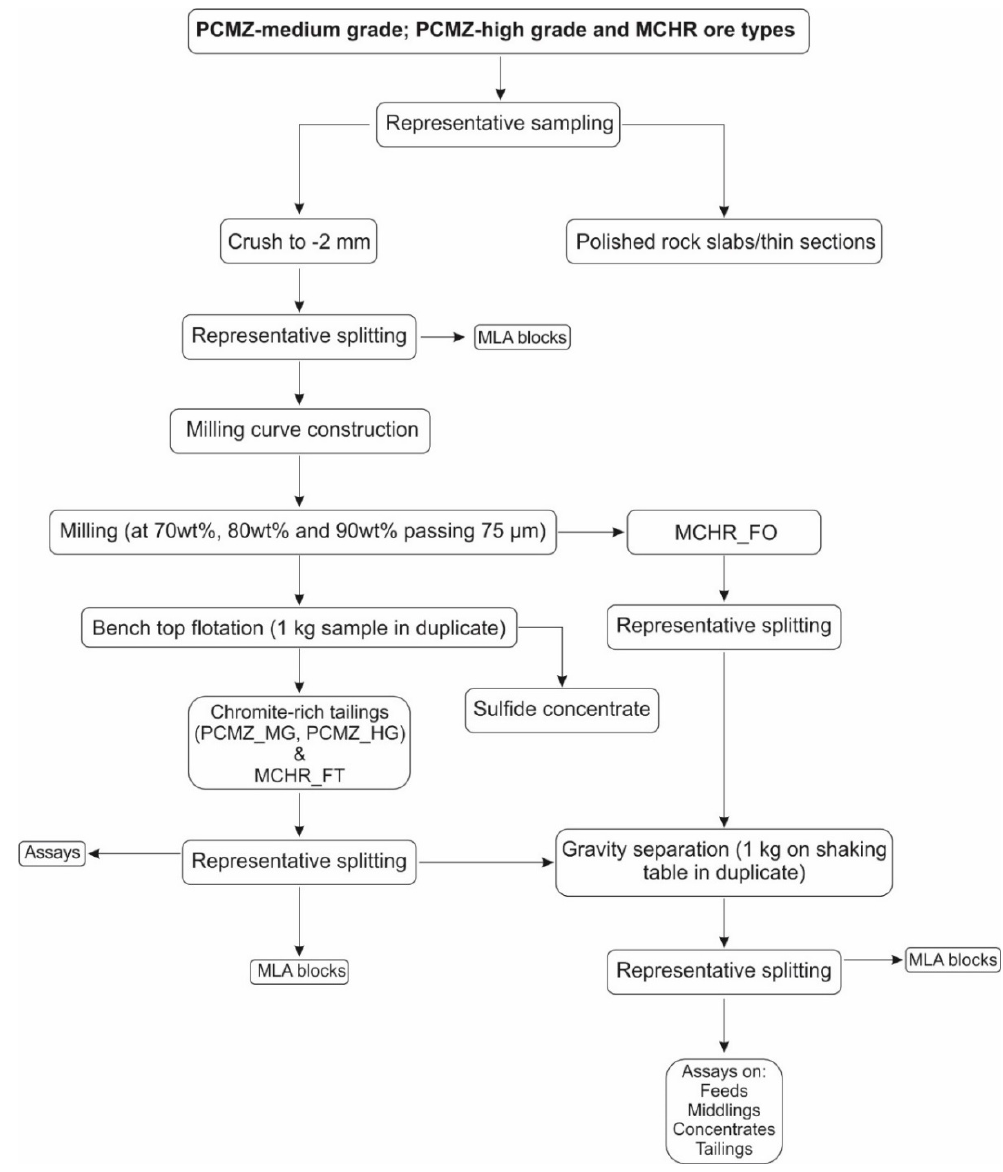
Figure 2. Sample tree showing handling and processing of samples from the study area.